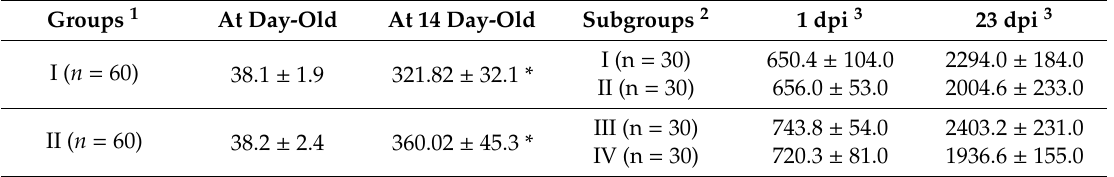
Table 3. Body weight performance in the groups and subgroups of growing chickens, g (M ± m). Groups 1 At